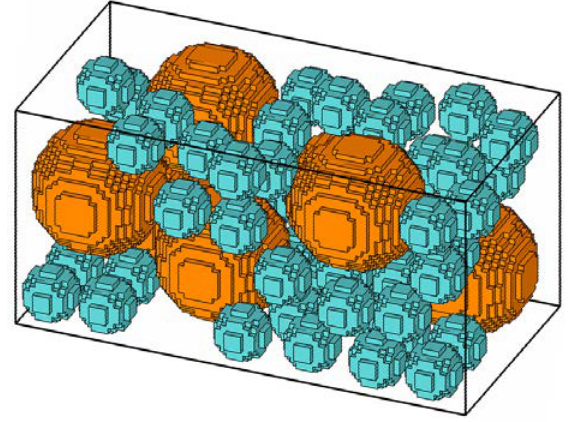
Fig. 9. Placement of voxelized balls into a parallelepiped